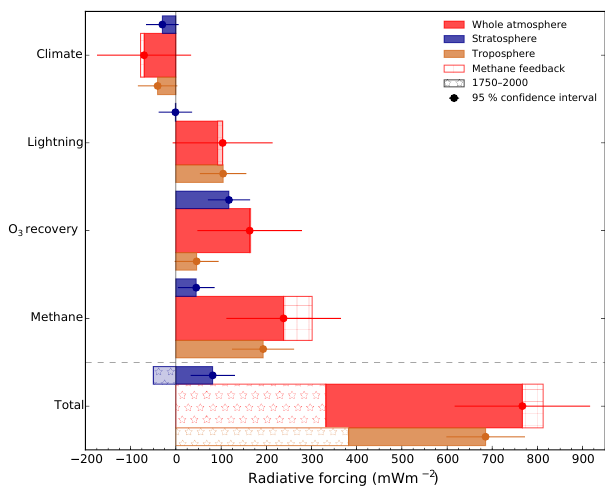
Figure 6. Ozone radiative forcings by drivers (2000– 2100;mWm − 2 ) . Tropospheric (brown), stratospheric (blue), and net (whole atmosphere, red) forcings are shown. Associated ozone forcings with methane feedback (square hatched) are shown along with the net forcings. The overall ozone forcing (total) is the sum of the individual forcings (climate, lightning, O 3 recovery, and methane from Table 3) scaled to 1750 (star hatched). Dots and error bars indicate the mean and the 95% confidence intervals of the forcings, respectively. The information on pre-industrial ozone forcing (1750–2000) and sources of uncertainty are detailed in Sect.